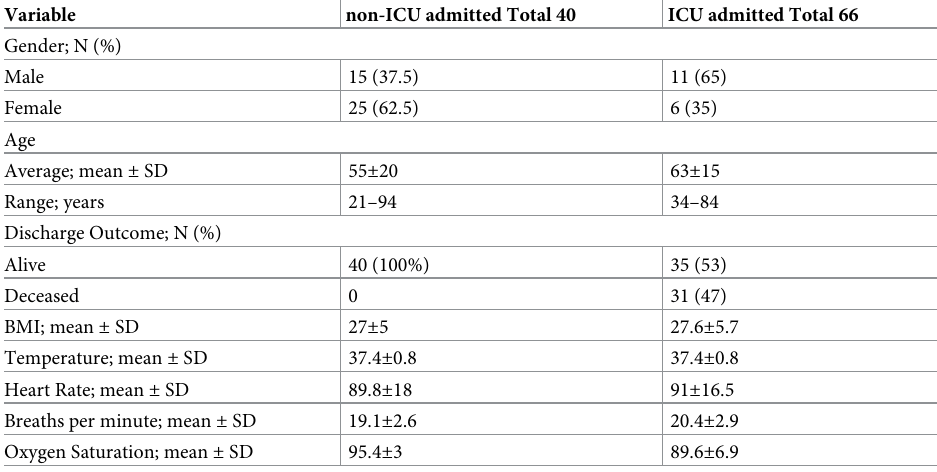
Table 2. Demographic characteristics of the COVID-19 positive patients demarcated into non-ICU and ICU